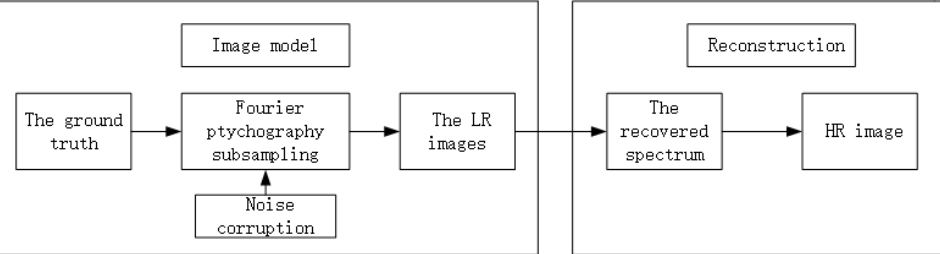
Figure 4. Framework for implementing long-range macro imaging.